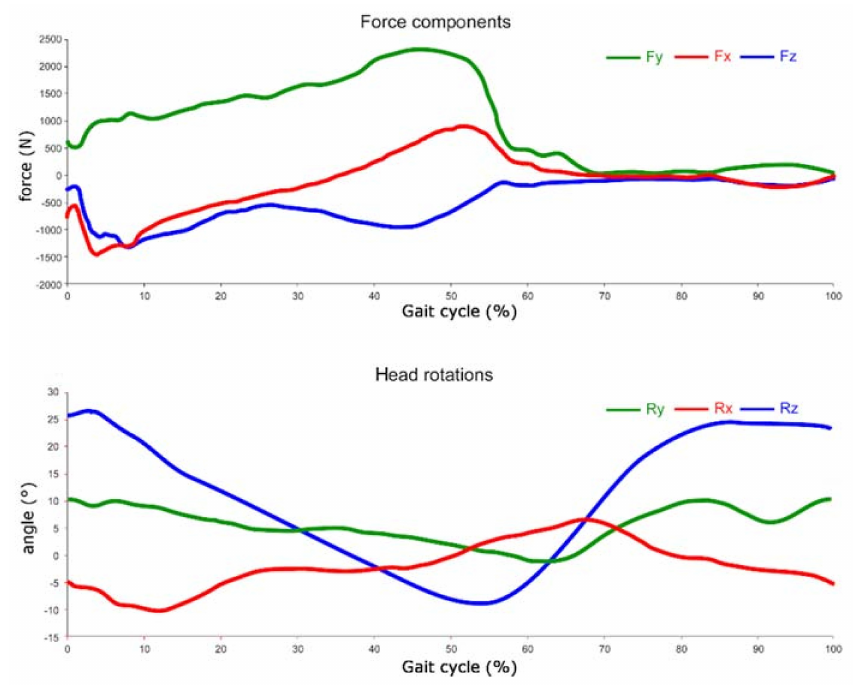
Figure 4. Forces and rotations obtained from